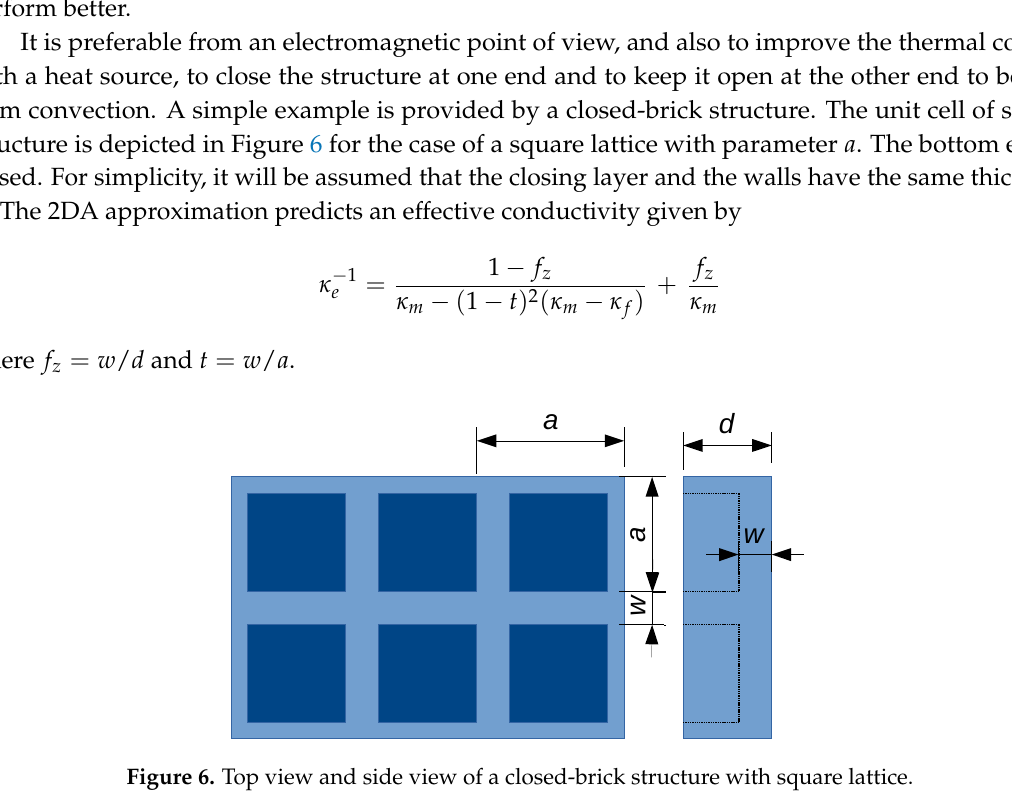
Figure 6. Top view and side view of a closed-brick structure with square